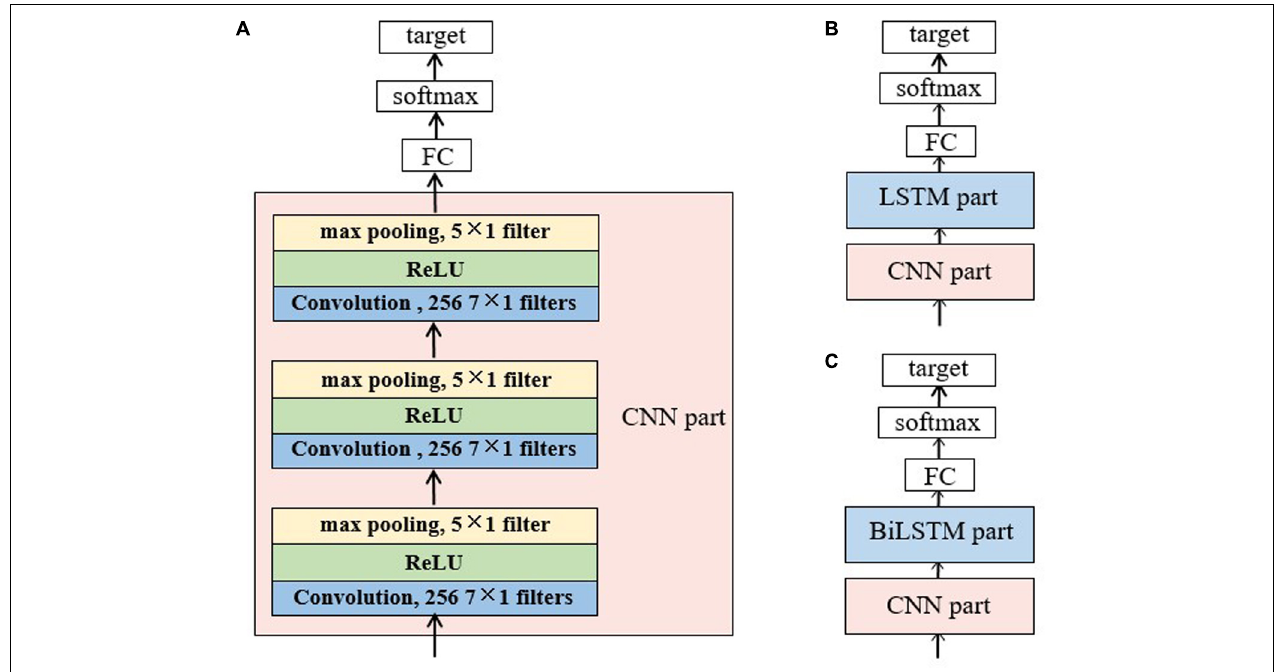
FIGURE 2 | Structure of the baseline networks for sleep staging: (A) the CNN network, (B) the CNN-LSTM network and (C) CNN-BiLSTM network. The CNN network consists of a CNN part, a full-connected layer and a softmax layer. In the CNN part, there are three convolution layers and three max pooling layers. Each convolution layer has 256 filters with a size of 7 × 1 each and each pooling layer has one filter of size 5 × 1. A rectified linear unit (ReLU) follows the convolution layer and precedes the pooling layer. The CNN part in panels (B,C) has the same topology with panel (A). For the LSTM/BiLSTM part, there are three stacked LSTM/BiLSTM layers with each layer consists of 256 memory cells. The target for all the networks was the probability of each sleep stage.